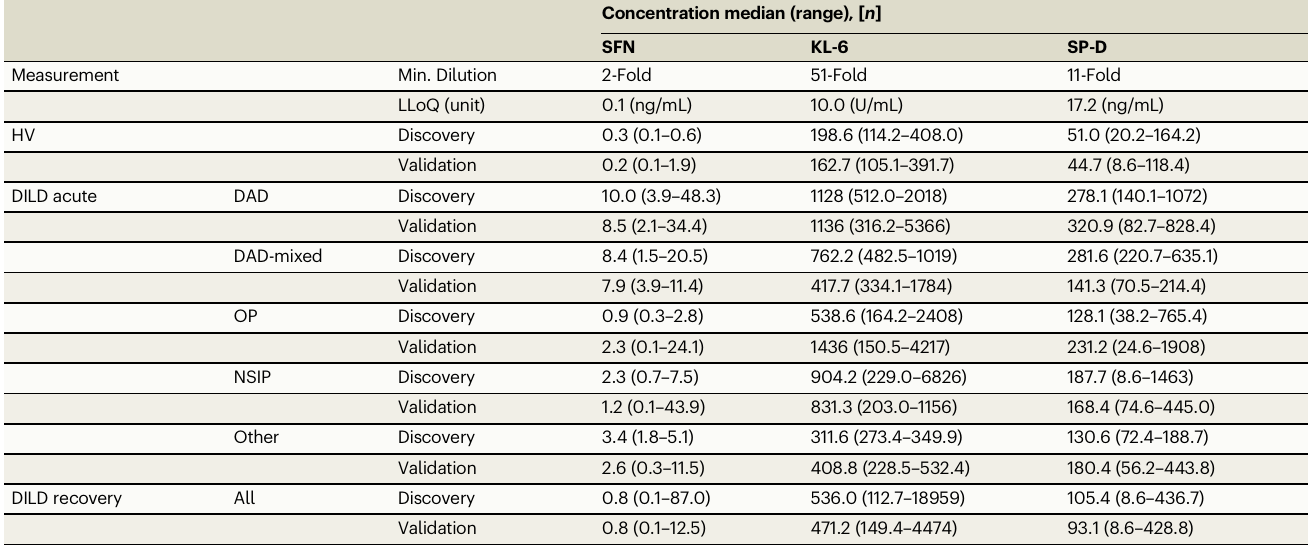
Table 2 | Comparison of the serum levels of SFN, KL-6, and SP-D in the Discovery and Validation